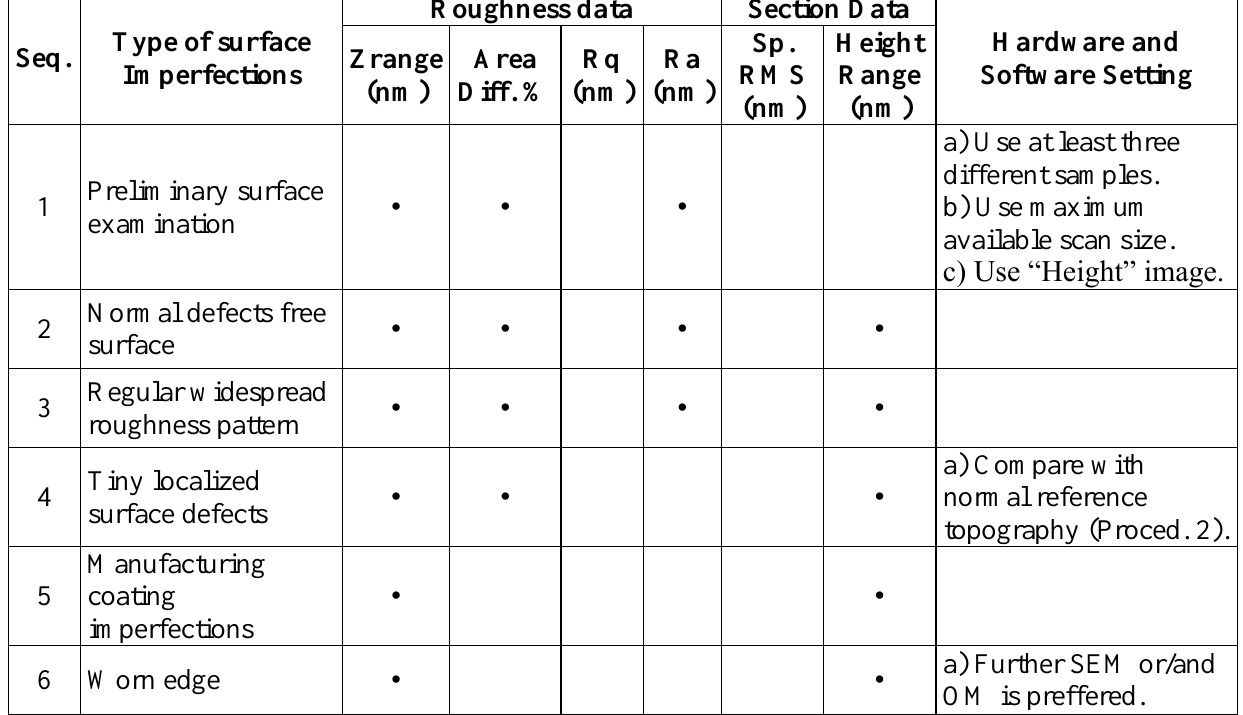
Table 4. The specification of the five coated and uncoated inserts used in this study.